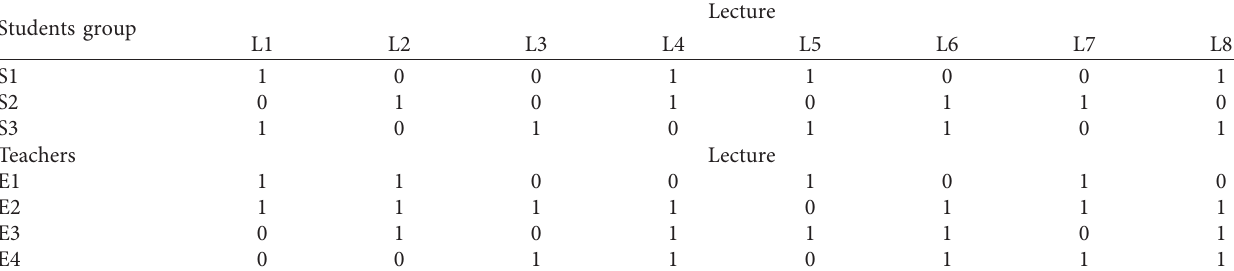
Table 7: Lectures offered for each group of students that each teacher teaches them.